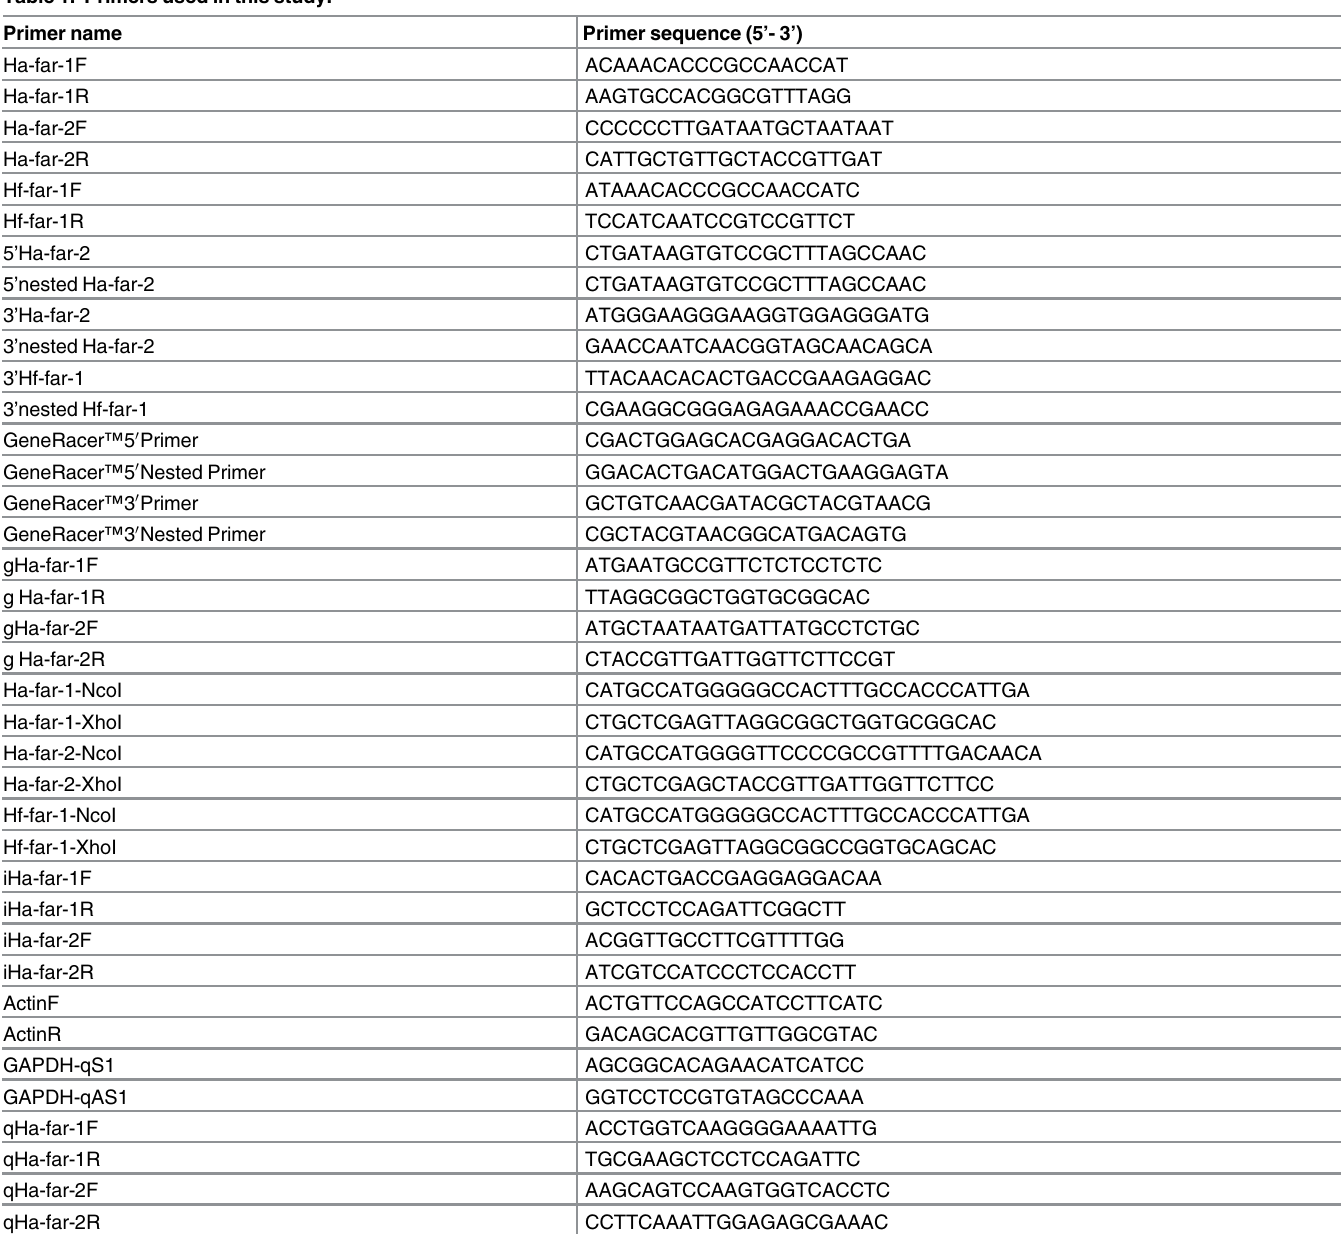
Table 1. Primers used in this